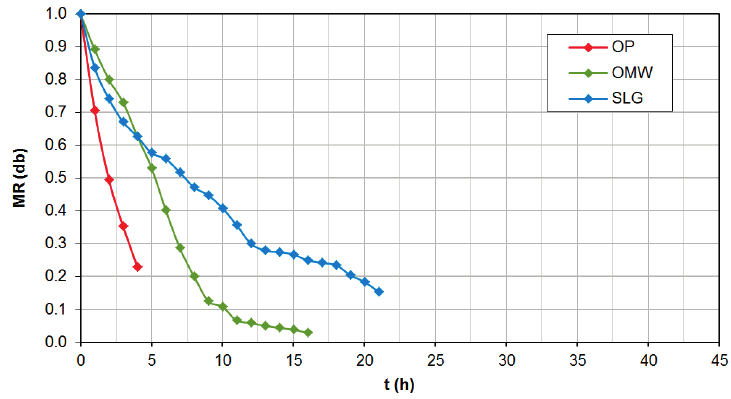
Figure 3. MR (db) mixed active mode.